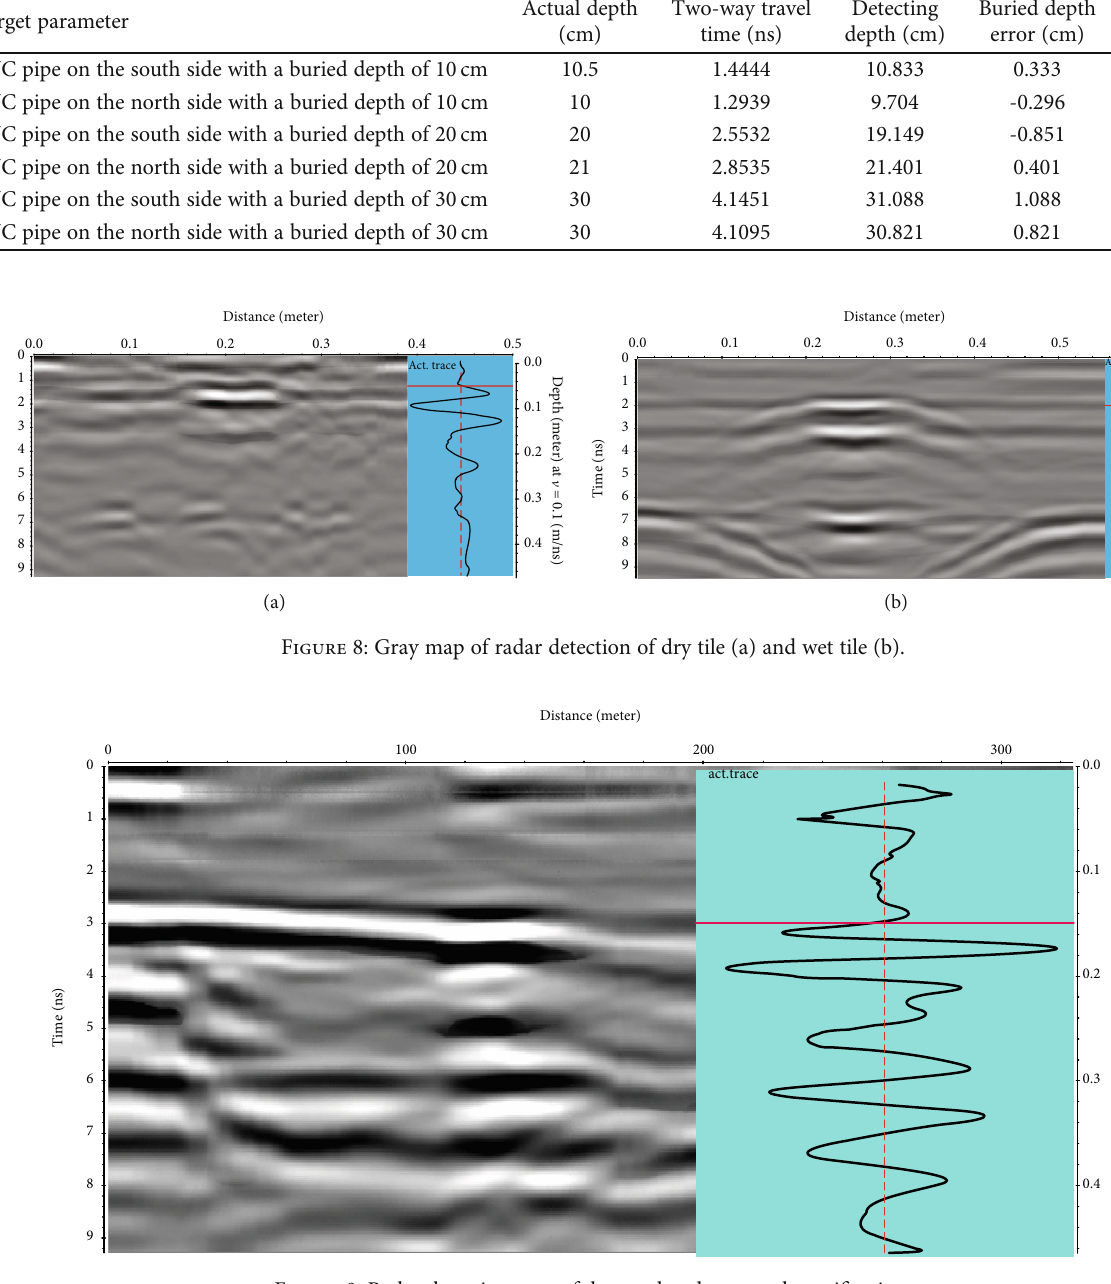
Figure 9: Radar detection gray of dry sand and wet sand strati fi